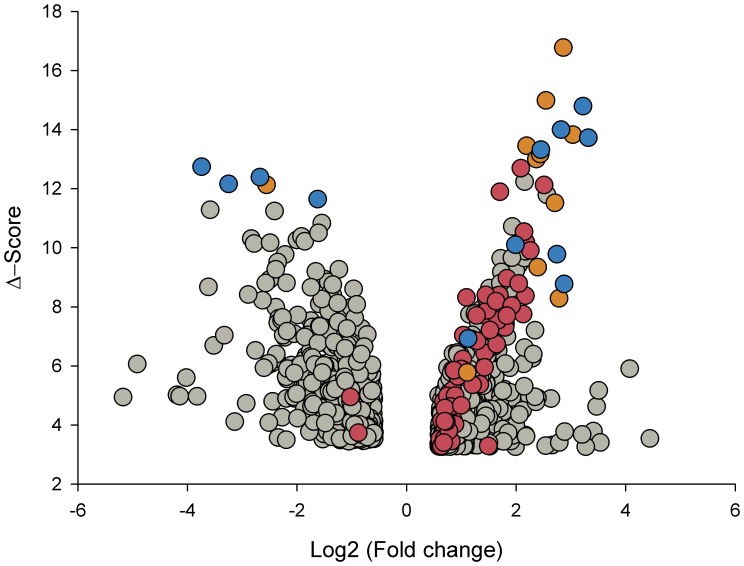
Distribution of deregulated genes according to the fold change (FC) and Δ-score values.All 997 genes (circles) that were deregulated in cervical cancer (CC) tumors compared to the control samples by the SAM method are graphed in a Volcano plot. The x-axis represents the FC in gene expression (cancer sample/control sample) expressed in Log2 and the y-axis display the absolute Δ-score, a modified t-test calculated with the SAM method, the higher the Δ-score values, the higher the statistical significance. The Log2 (FC) values are positive for upregulated genes and negative for downregulated genes. Circles colored in red and orange represent the genes involved in M-phase of the cell cycle and those colored in blue and orange are the genes that were validated by qRT-PCR.